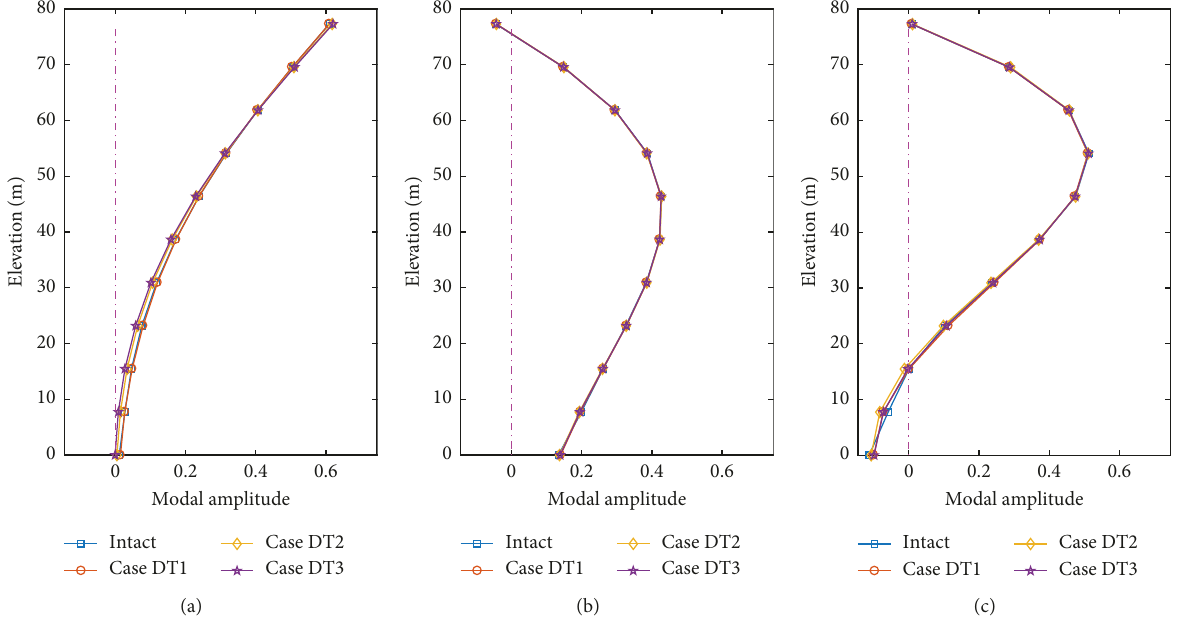
Figure 15: Along-wave bending mode shapes: damage type 1. (a) Mode Bx1. (b) Mode Bx2. (c) Mode Bx3.